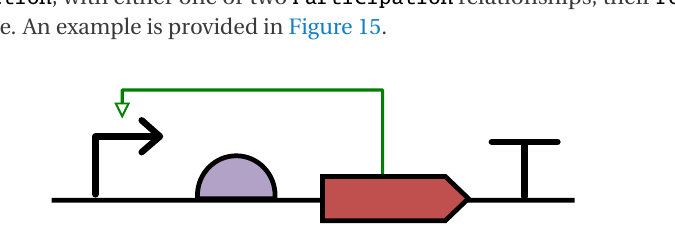
Figure 15: Example of an interaction indicating a promoter stimulated by the CDS that it regulates.